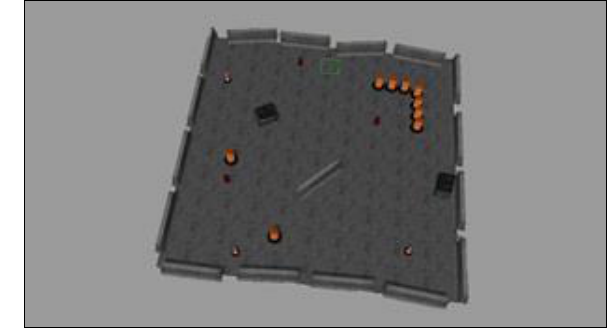
Figure 6. Simulated environment in Gazebo